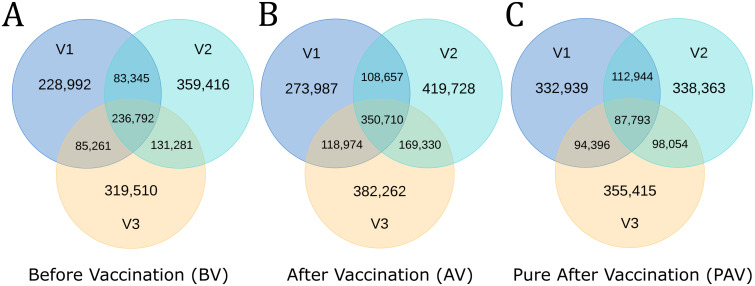
Venn diagrams showing the structural overlap between each individual’s A: ‘Before Vaccination’ dataset, B: ‘After Vaccination’ dataset, and C: ‘Pure After Vaccination’ dataset (distinct structures arising only after vaccination).Total distinct structures: Before Vaccination—1,444,597; After Vaccination—1,823,628; Pure After Vaccination—1,419,904. V1-V3 = Volunteer 1-3.